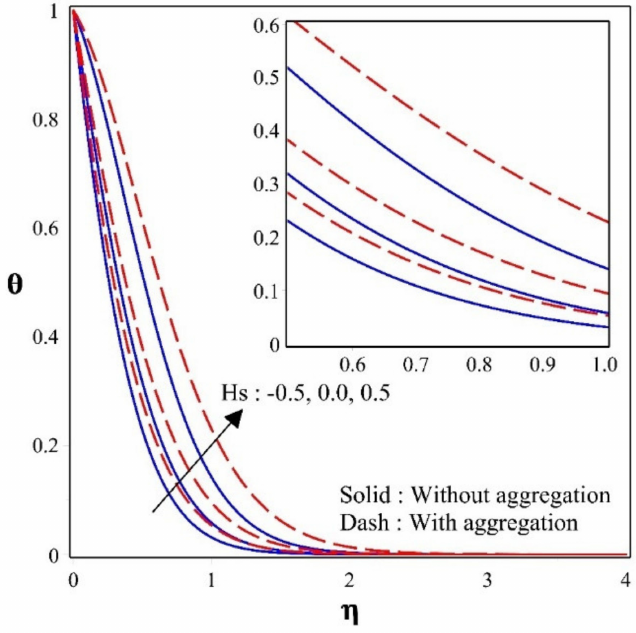
Figure 4. Sway of θ for different values of Hs